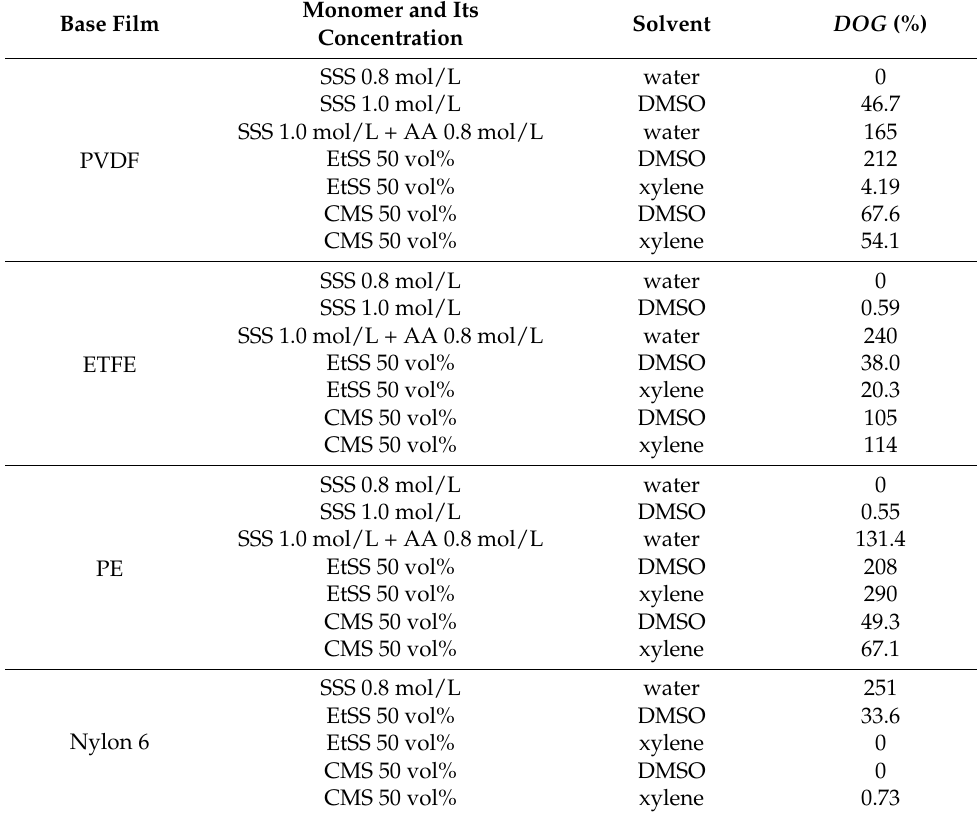
Table 3. Results of the radiation grafting of monomers into various base